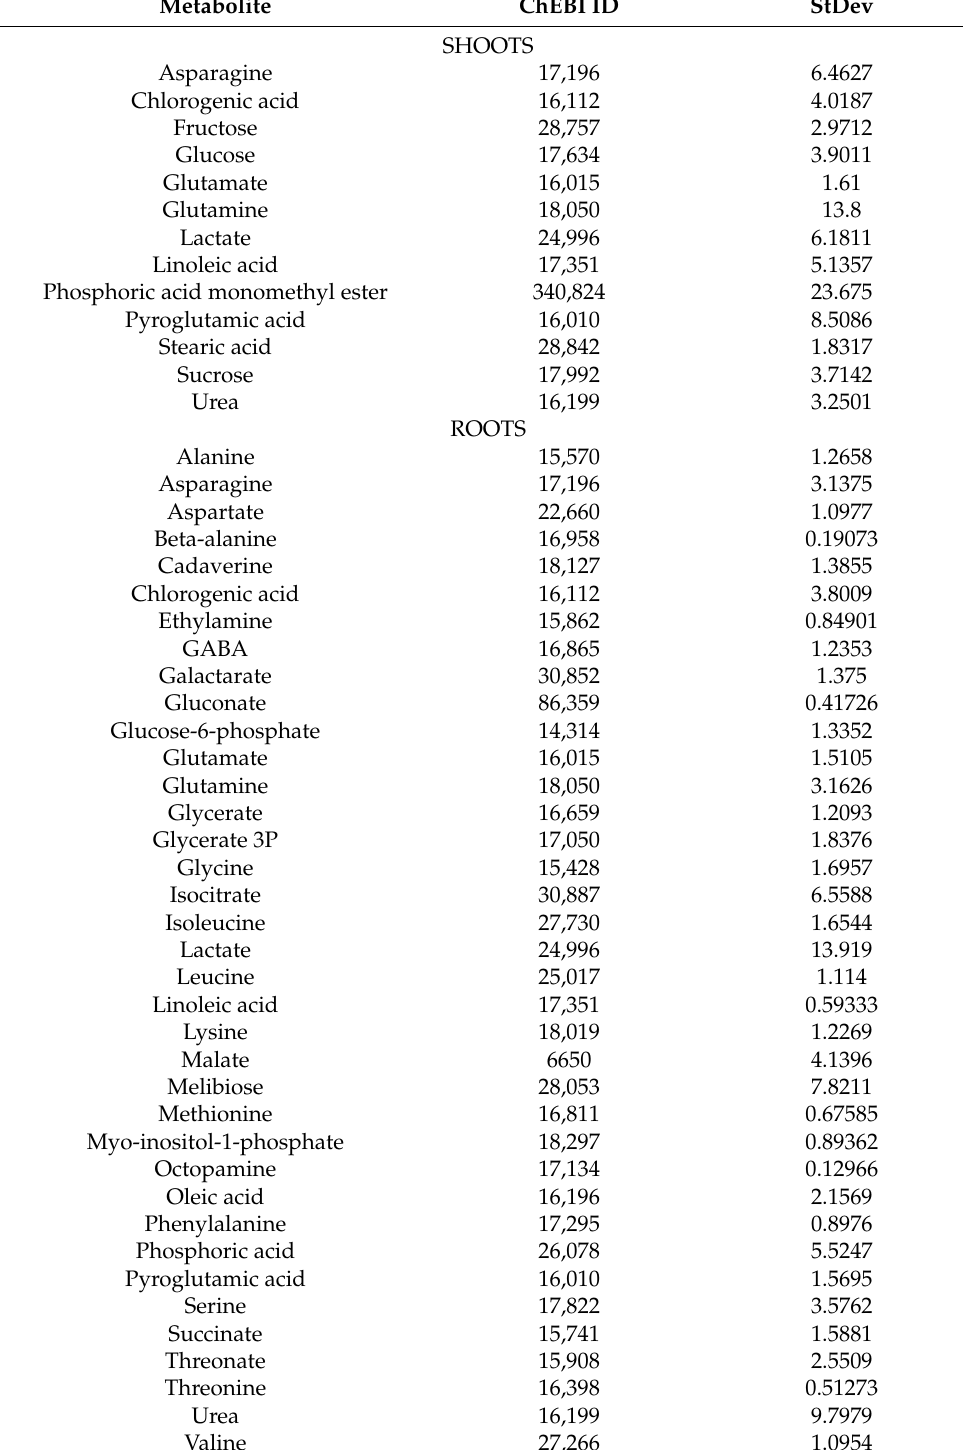
Table 1. Metabolites that show significantly higher abundances in both, shoot and roots from tomato seedlings treated with affinin, using the statistical significance analysis of microarray (SAM)